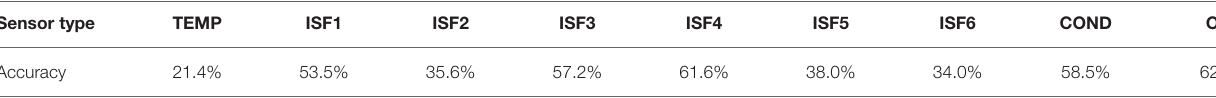
TABLE 5 | Individual accuracies reached by a k-NN classifier when using single sensor channels. Sensor type